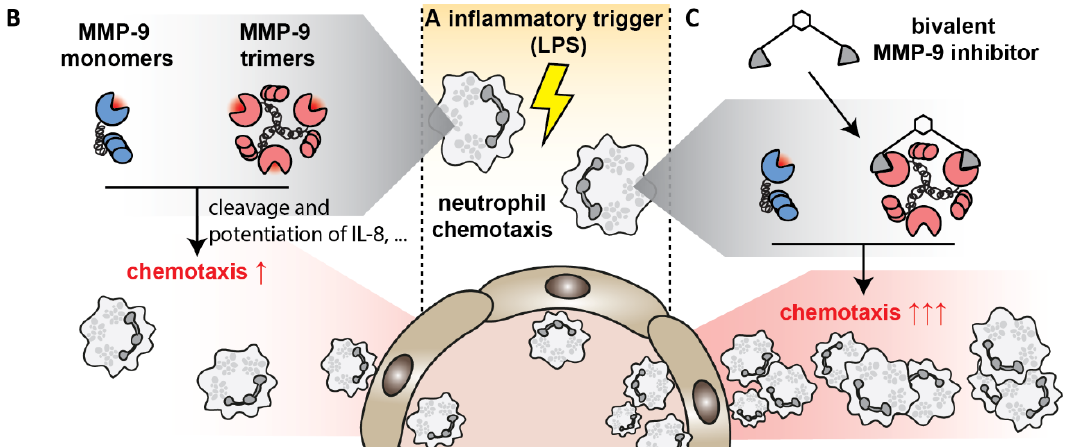
Figure 7. Study overview. ( A ) At early stages in infections or inflammations, neutrophils migrate towards an inflammatory stimulus (e.g., E. coli LPS) and release proteolytic or bactericidal proteins, including MMP-9; ( B ) through actions such as the cleavage and potentiation of the early neutrophil chemoattractant CXCL8/IL-8, MMP-9 further stimulates neutrophil recruitment; ( C ) whereas general inhibition of MMP-9 mixtures tempers inflammation, our results show that specific inhibition of the trimeric proteoform of MMP-9 further increases neutrophil chemotaxis, suggesting a role for MMP-9 trimers in tempering excessive neutrophil migration.